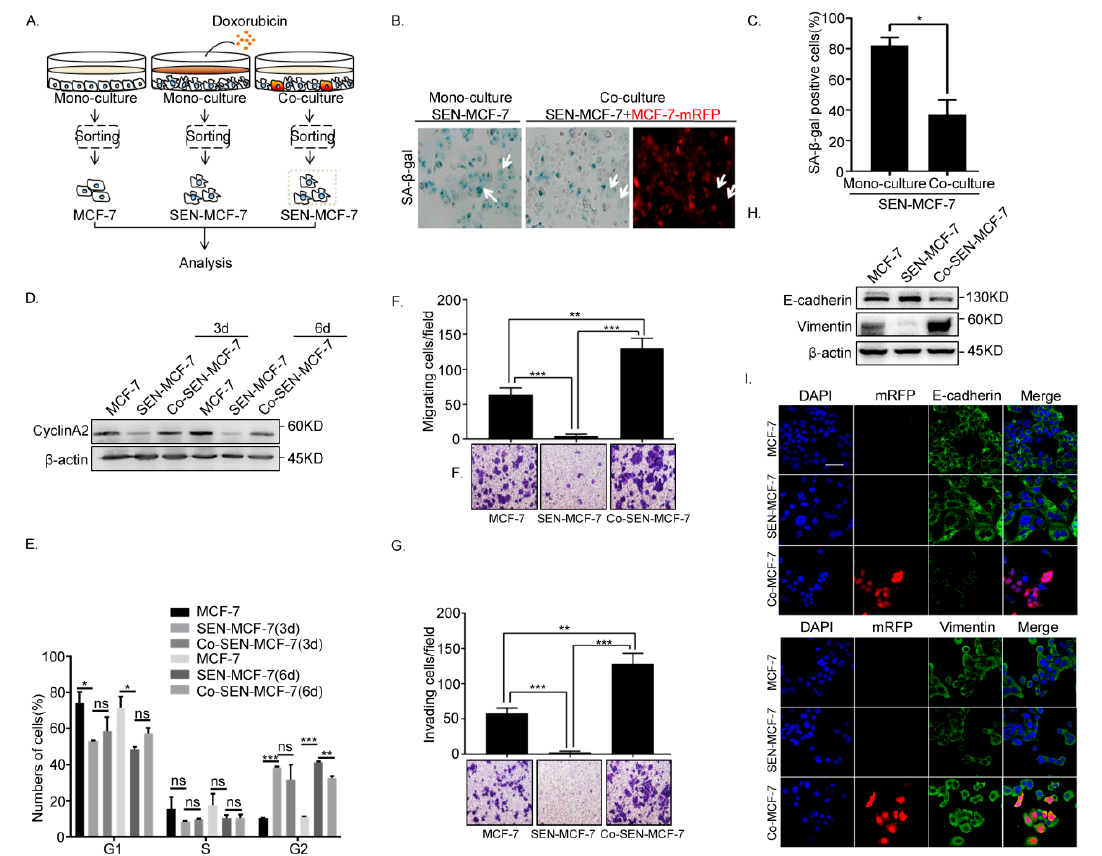
Figure 2. Senescent MCF-7 cells re-entered the cell cycle and underwent EMT in the co-culture. ( A ) Left: Scheme showing the experimental setup. Flow cytometry sorting of collected senescence breast cancer cells (Co-SEN-MCF-7) co-cultured with MCF-7-mRFP for 3 or 6 days. ( B , C ) β -Gal staining analysis of MCF-7 cells subjected to the indicated treatments and fluorescence microscopy of MCF-7-mRFP cells. Arrow, senescent MCF-7 cells (SEN-MCF-7 and Co-SEN-MCF-7). ( B ) Representative images. ( C ) Percentage of β -gal positive cells (error bars indicate the mean SD, n = 3 experimental replicates, * p < 0.05). ( D ) Right: Immunoblot analysis of protein expression of cyclinA2 in MCF-7 cells with the indicated treatments. ( E ) Cell cycle analysis of MCF-7 cells with the indicated treatments. Percentages of cell subpopulations at different cell cycle phases based on triplicate experiments (Error bars indicate mean SD, n = 3 experimental replicates, * p < 0.05, ** p < 0.01, *** p < 0.001). ( F ) Migration assays of MCF-7 cells with the indicated treatments. Representative micrographs of migrated cells are shown. Data represent the number of cells derived from mean cell counts of five fields (error bars indicate mean SD, n = 3 experimental replicates, ** p < 0.01, *** p < 0.001). ( G ) Invasion assay of MCF-7 cells with the indicated treatments. Representative micrographs of migrated cells are shown. Data represent the number of cells derived from mean cell counts of five fields (Error bars indicate mean SD, n = 3 experimental replicates, ** p < 0.01, *** p < 0.001). ( H ) Immunoblot analysis of protein expression of the epithelial marker, E-cadherin, and mesenchymal marker, Vimentin, in MCF-7 cells subjected to the indicated treatments. ( I ) Immunofluorescence staining of EMT markers in MCF-7 cells subjected to the indicated treatments. Scale bar, 50 μ m.